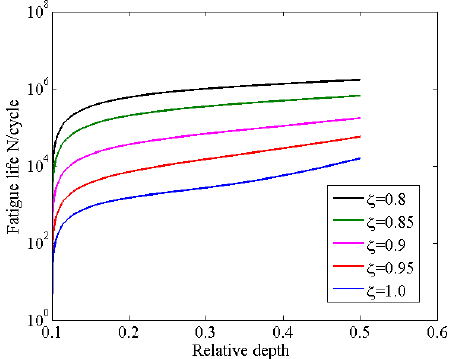
Figure 6. Vibration fatigue life curves with different ζ .